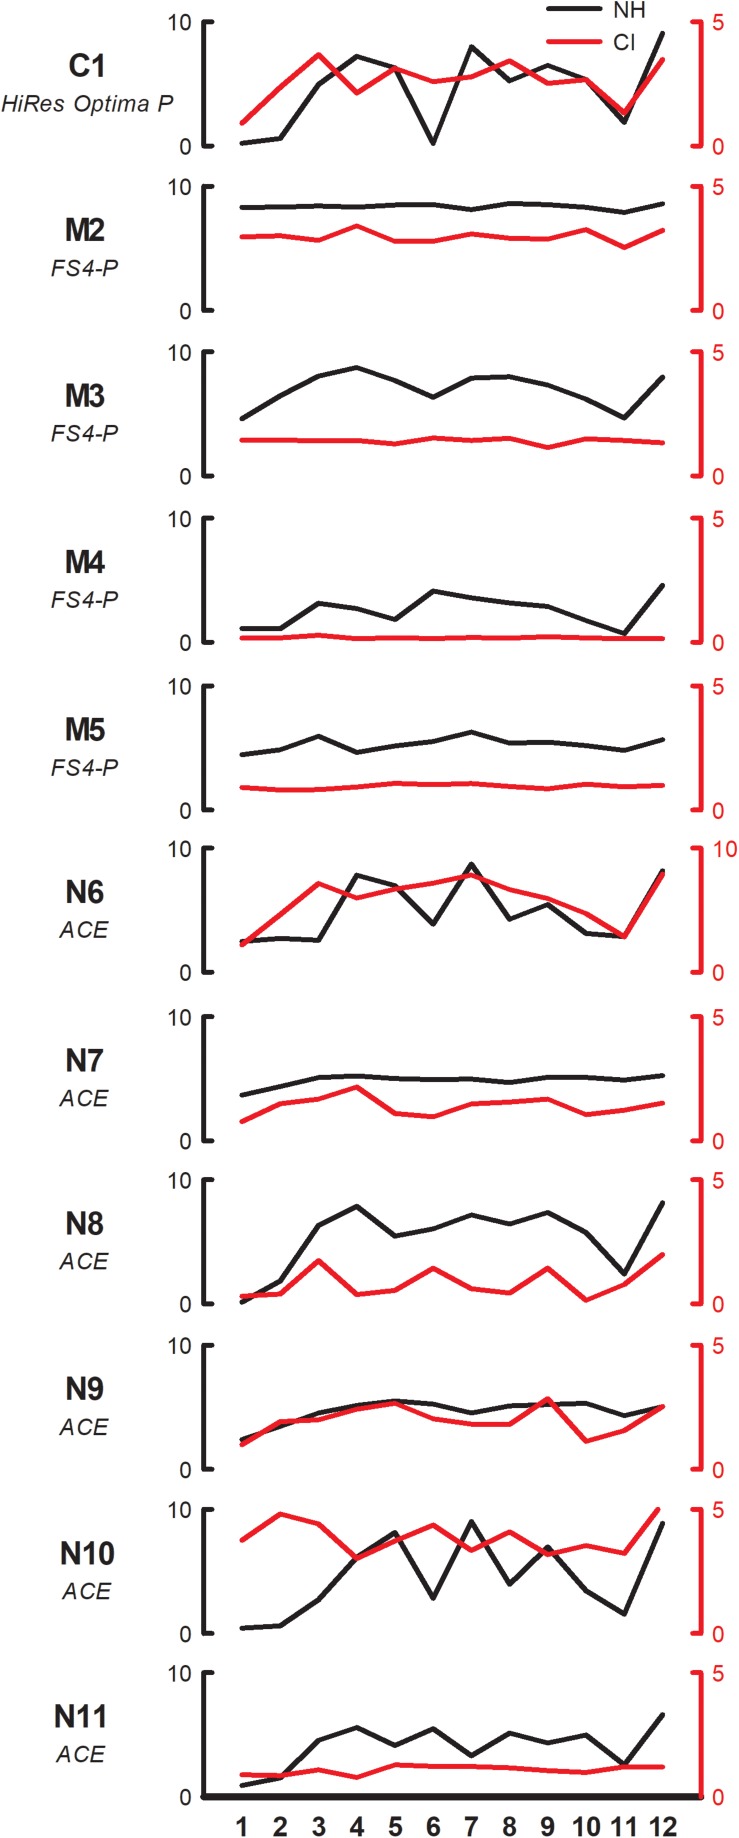
Pleasantness ratings for individual SSD-CI participants with NH-only (black, left ordinate) and CI-only listening (red, right ordinate), for the F3 root note (within-octave) as a function of interval size. Note that the scale for CI-only ratings is half of that for NH-only ratings for all participants except N6. The clinical CI signal processing strategy is listed under each subject’s code.